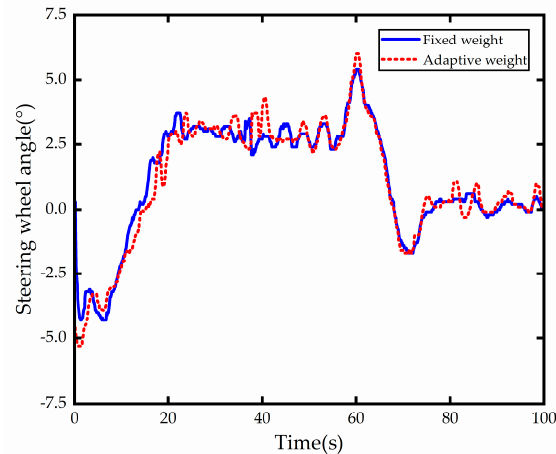
Figure 15. Longitudinal vehicle speed.